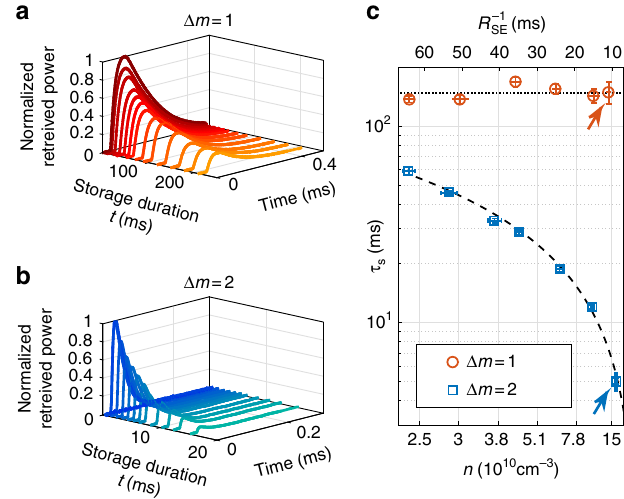
Fig. 3 Storage lifetime. a , b Retrieved pulses for several storage durations in our scheme Δ m = 1 ( a ), compared to the standard scheme Δ m = 2 ( b ). The lifetime in our scheme is longer than 100 ms, compared to only a few ms in the standard scheme. c Storage lifetime as a function of atomic density n and spin-exchange rate R SE in our scheme (red), which is unaffected by collisions and thus remains constant (dotted line). In contrast, the lifetime in the standard scheme (blue) is well described by a linear fi t (dashed line). Data in a , b correspond to points marked by arrows in c . The two schemes exhibit comparable storage lifetimes only at low atomic densities, where the optical depth and thus the storage ef fi ciency are compromised 3 . Vertical error bars are 95%-con fi dence intervals of the exponential fi t to storage ef fi ciency; horizontal error bars are 95%-con fi dence intervals of the spin exchange rate, measured at high magnetic fi elds before and after each experimental sequence